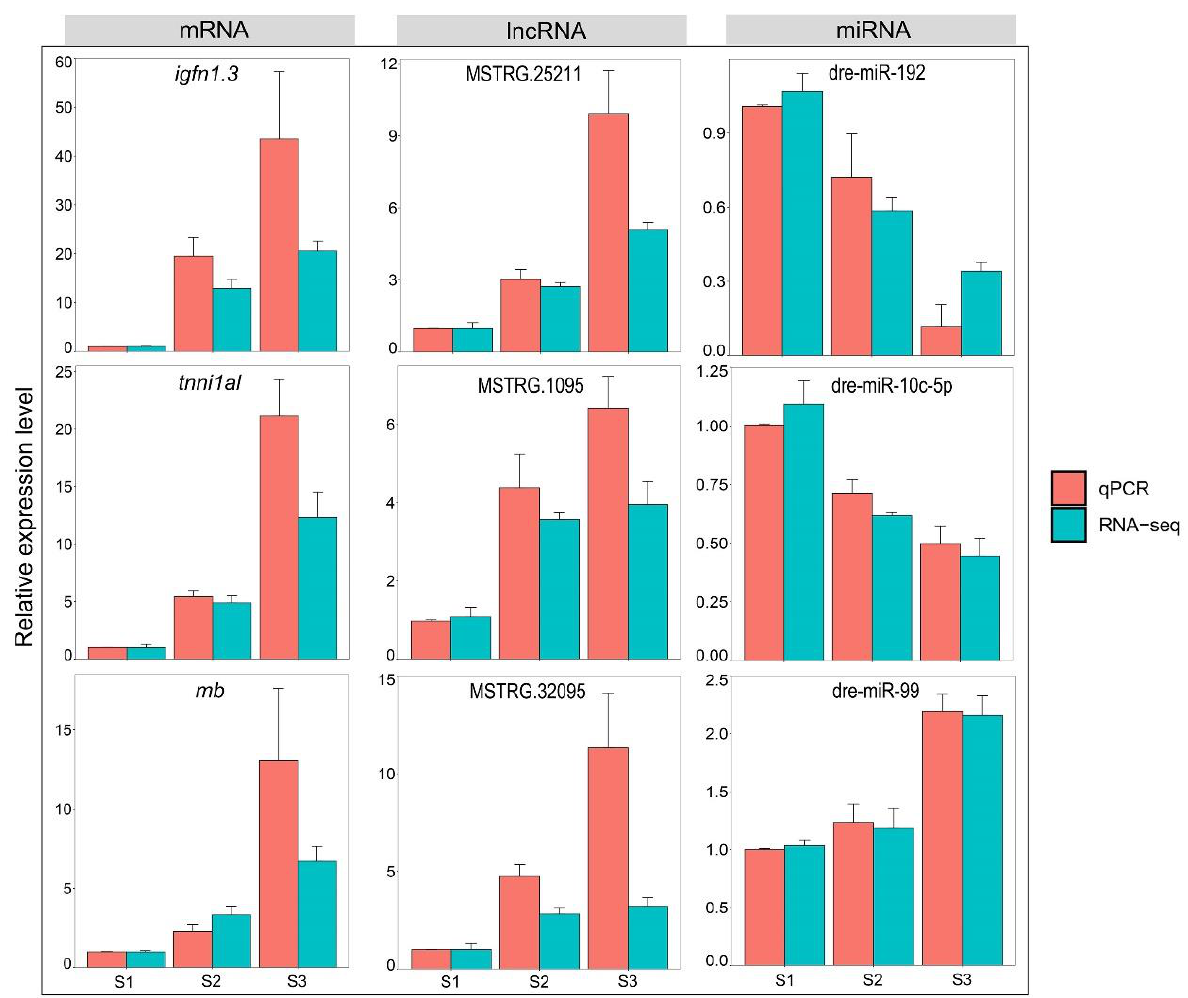
Figure 5. Comparison of RNA-seq data and RT-qPCR data.